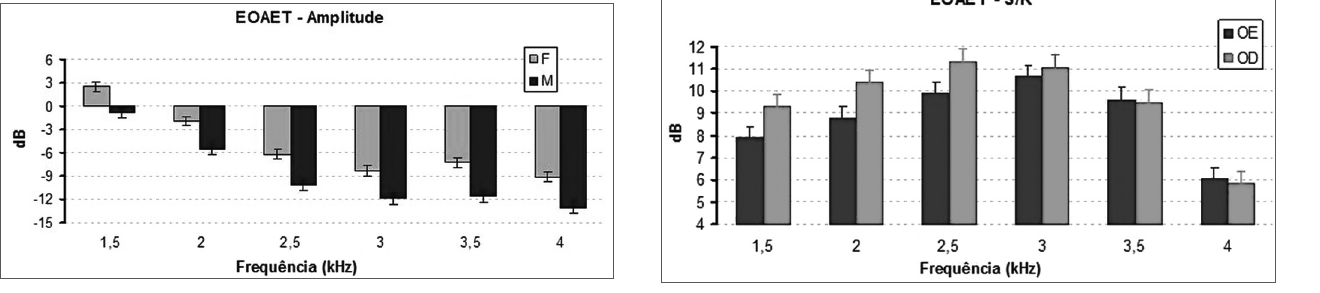
Figura 4. Média e desvio padrão das relações sinal/ruído das EOAT registradas para cada orelha em cada frequência. S/R: relação sinal/ ruído; OE: Orelha esquerda; OD: Orelha direita. Teste ANOVA, p =